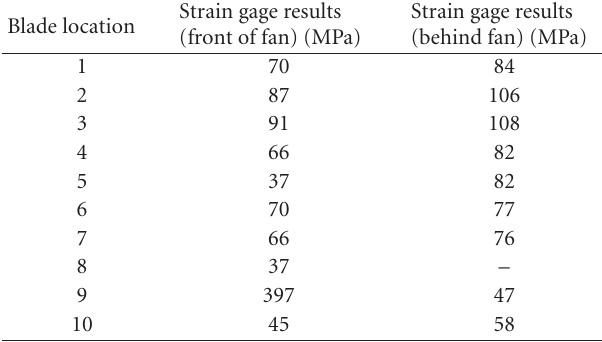
Table 2: Strain gage results comparison (with radiator). Strain gage results Blade location